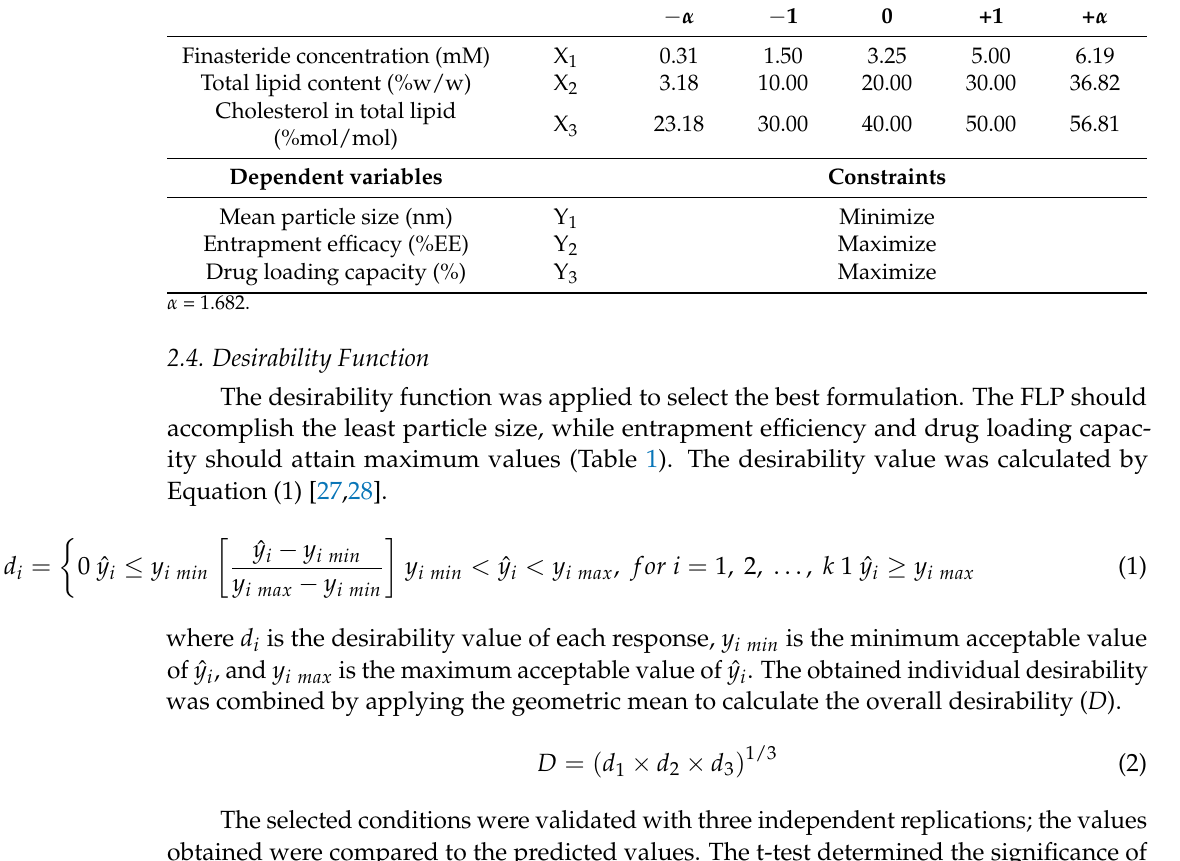
Table 1. Independent variables, symbols, coded levels, and actual values of the experimental design. Independent Variable Symbol Code Levels − α Finasteride concentration (mM)